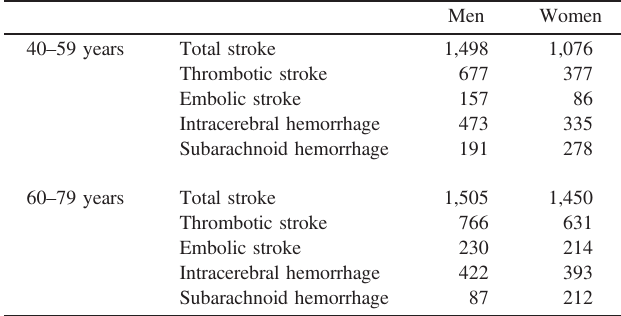
Table 1. The number of cases included in the present